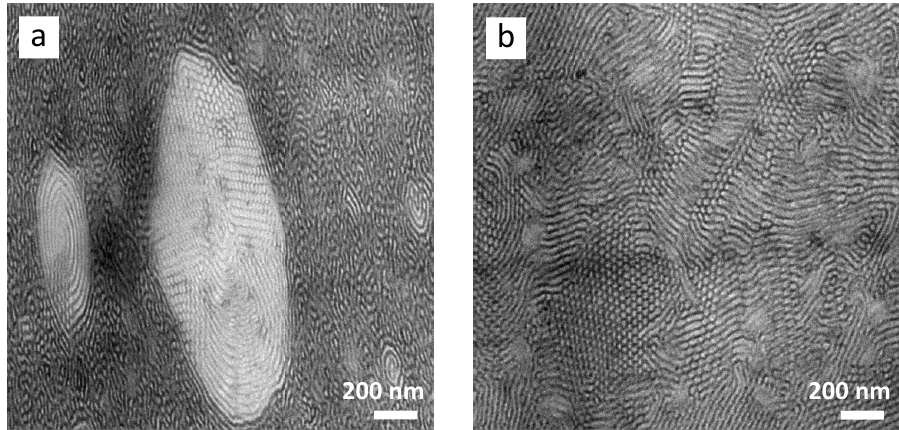
Figure 6. Local structural effects in the morphology of epST-38 ( a ) and epST-82 ( b ).